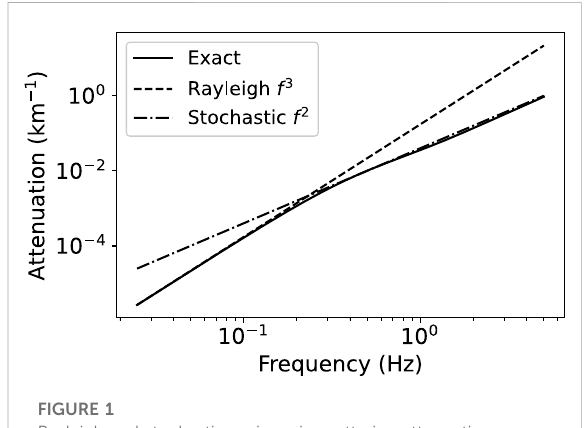
FIGURE 1 Rayleigh and stochastic regimes in scattering